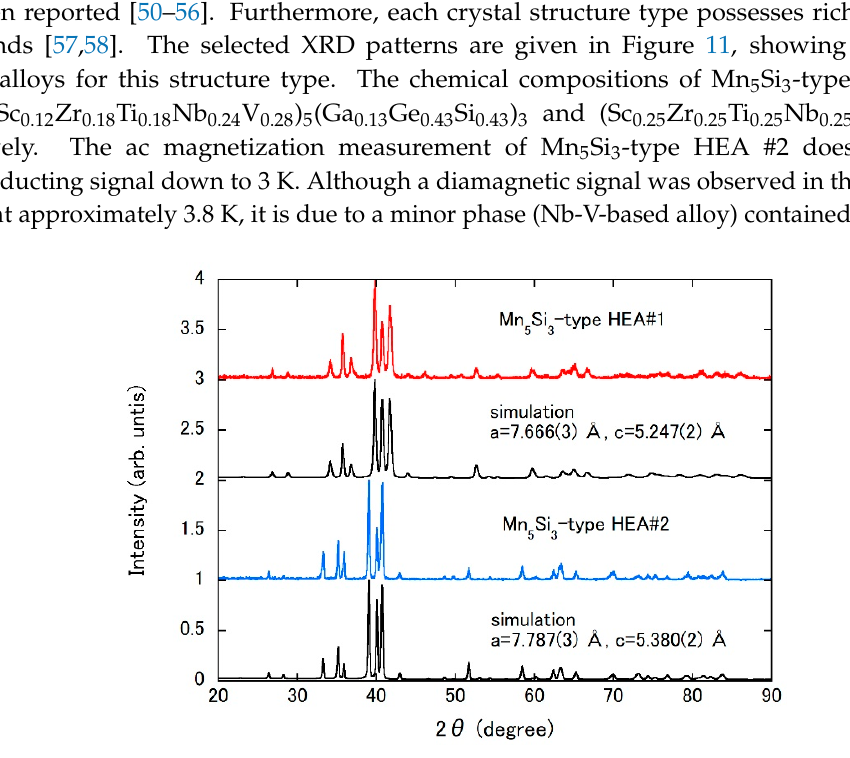
Figure 11. XRD patterns (Cu-K α ) of Mn 5 Si 3 -type HEAs. The simulation patterns are also shown. Each pattern is shifted by an integer value for clarity. The lattice parameters were determined with the help of the Rietveld refinement program [38,39].